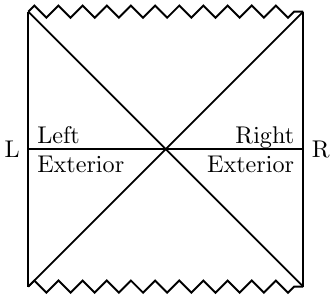
Figure 6. Penrose diagram for the eternal AdS-Schwarzschild black hole. Note that the two boundaries, R and L, have topology R (cid:2) S D (cid:0) 1 where D is the dimension of the bulk spacetime.